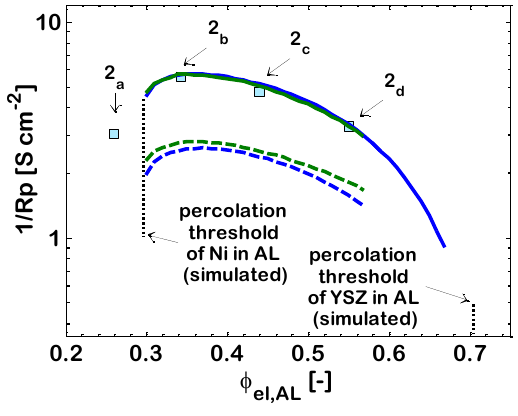
Figure 2. 1 /R of bi-layered Ni-YSZ anodes operating at: T = 973 K (dashed lines); p and T = 1073 K (solid lines); overall current density: I I = 0.5 A/cm 2 . Lines: simulation. Points: literature experimental data (2 tot and 2 ) d